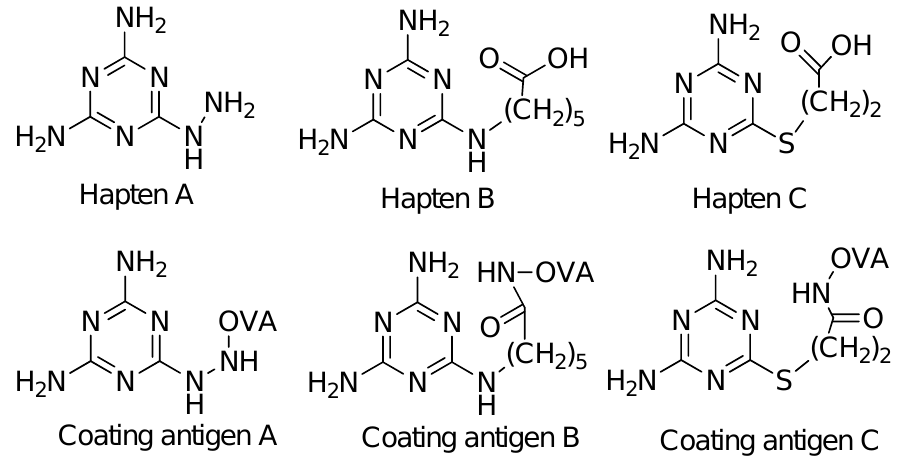
Figure 2. Chemical structures of haptens and coating